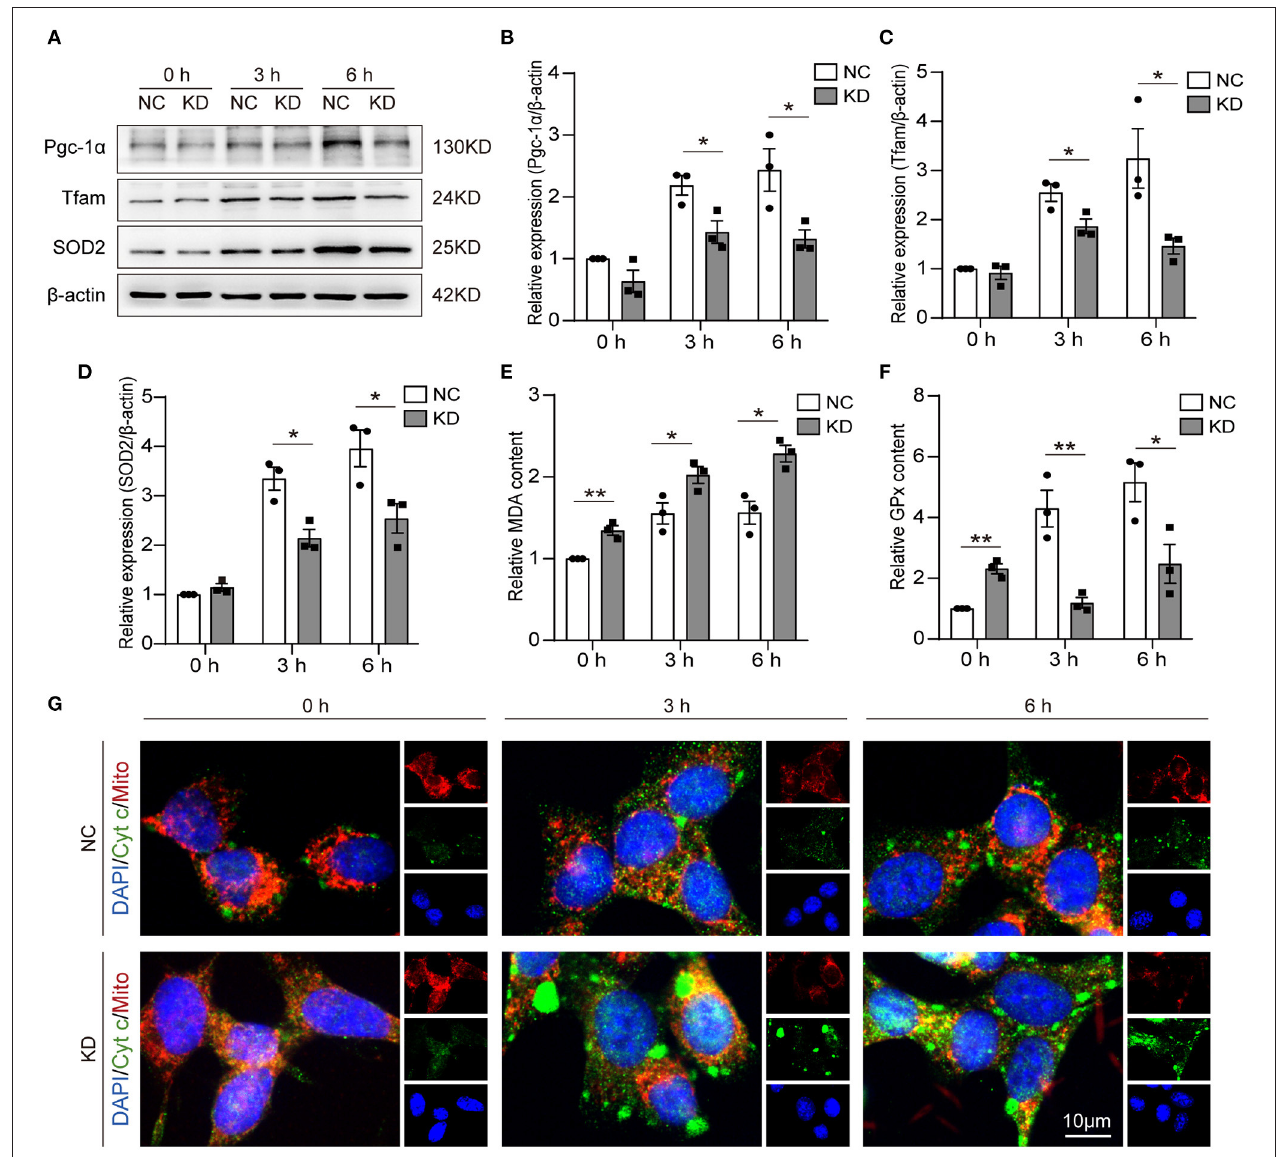
FIGURE 5 | Knockdown of Fos aggravated oxidative stress and impaired mitochondrial function. (A–D) Representative bands and quantification of SOD2, Pgc-1 α , and Tfam from WB. (E) MDA levels were assessed in Fos knockdown cells after OGD. (F) GPx levels were assessed in Fos knockdown cells after OGD. (G) Representative immunofluorescence microphotographs of the NC and KD groups at each time point after OGD. Mitochondria (Mito) and Cytochrome c (Cyt c) were labeled by red and green puncta, respectively; the nuclear (DAPI) was labeled by blue. Scale bar = 10 µ m. Each result is expressed as the mean of three independent experiments ± SEM. * p < 0.05, ** p < 0.01. NC, negative control cells; KD, knock-down